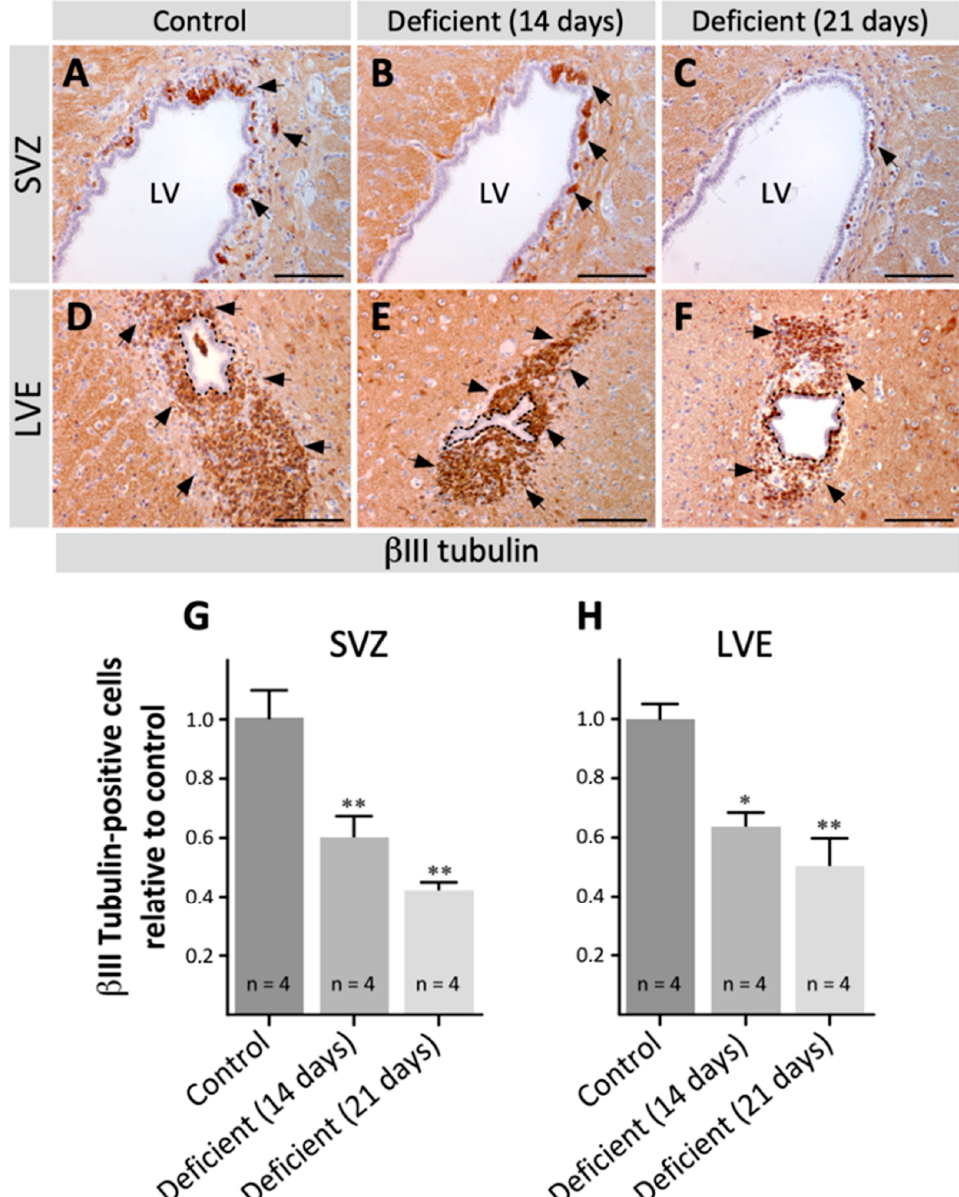
Figure 1. Analysis of neuroblasts in the brain of adult vitamin-C-deficient guinea pigs. Coronal sections of the brain of control guinea pigs ( A , D ) and the brain of guinea pigs with 14 ( B , E ) and 21 days ( C , F ) of vitamin C deficiency, labeled with anti- β III tubulin (1:1000) to identify neuroblasts. In the SVZ ( A – C ) and LVE ( D – F ), neuroblasts progressively decreased with increasing days of vitamin C deficiency (arrows). ( G , H ) Neuroblasts were quantified in the SVZ ( G ) and LVE ( H ) of control and vitamin-C-deficient animals. The number of neuroblasts decreased progressively from the control animals to the 21-day deficient animals in both the SVZ and LVE. Data are presented as mean ± SD. Statistical analysis was performed using one-tailed ANOVA test and Bonferroni post-test; * p < 0.05, ** p < 0.01. n = 4. SVZ: subventricular zone. LV: lateral ventricle. LVE: lateral ventricle extension. Scale bar: 100 µ